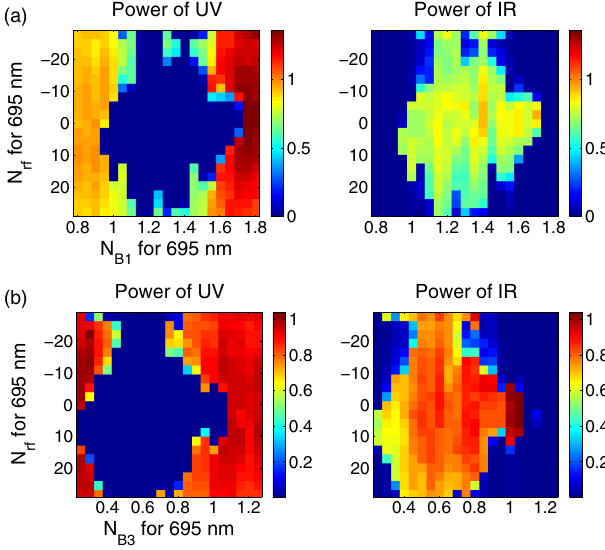
FIG. 11. Two-color lasing power in phace space with the four- undulator configuration and loss curves L3. N (y-axis) is the rf rf detune expressed in length normalized to λ 1 ¼ 695 nm. (a) N vs rf N N ¼ 0 . 60 for 695 nm). The mean B 1 , while fixing B3 setting ( B 3 wavelength of IR and UV lasings are 697.52 nm and 368.40 nm, respectively. (b) N vs N B 3 , while fixing B1 setting ( N B 1 ¼ 0 . 25 rf for 695 nm). The mean wavelength of IR and UV lasing are 694.32 nm and 367.97 nm, respectively. In both cases, the rf ¼ − 27 . 69 ) to 0.5 Hz detune is scanned from − 0 . 5 Hz ( N rf ¼ 27 . 69 ). K ¼ 3 . 45 , K ¼ 3 . 26 and N ¼ 0 . 77 ( N B 2 rf OK − 4 OK − 5 for 368 nm. The beam current is maintained between 12.3 mA and 13.0